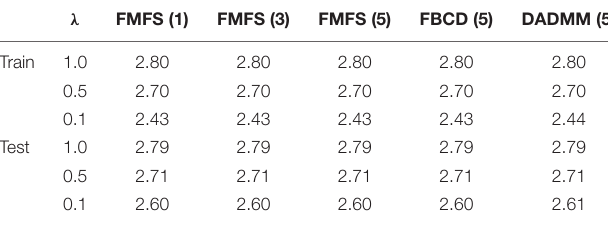
TABLE 5 | Average RMSE for predicting MMSE with FMFS across different institutional settings.